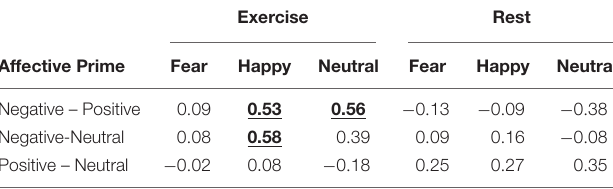
TABLE 2 | Estimation statistics on trajectories’ Maximum Deviation.